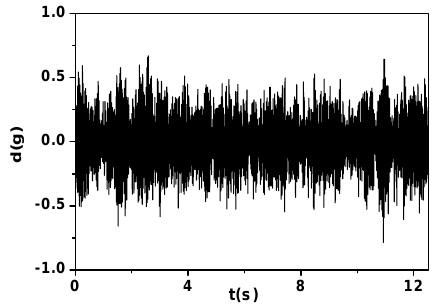
Fig. 24. Response of the first accelerometer for case C 6 .